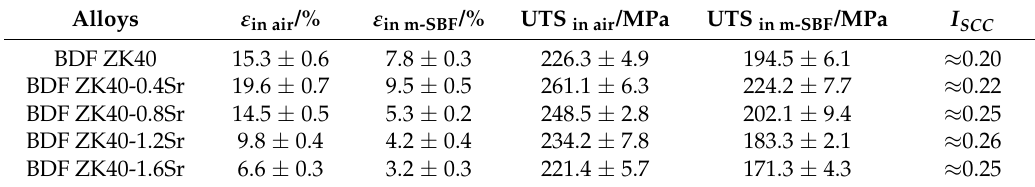
Figure 5. Tensile stress-strain curves of the BDF ZK40-xSr alloys tested in air and in m-SBF at 37 ± 1 ◦ C. ( a ) ZK40; ( b ) ZK40-0.4Sr; ( c ) ZK40-0.8Sr; ( d ) ZK40-1.2Sr; ( e ) ZK40-1.6Sr. Table 2. Summary of SSRT results and the I SCC of the BDF ZK40-xSr alloys.